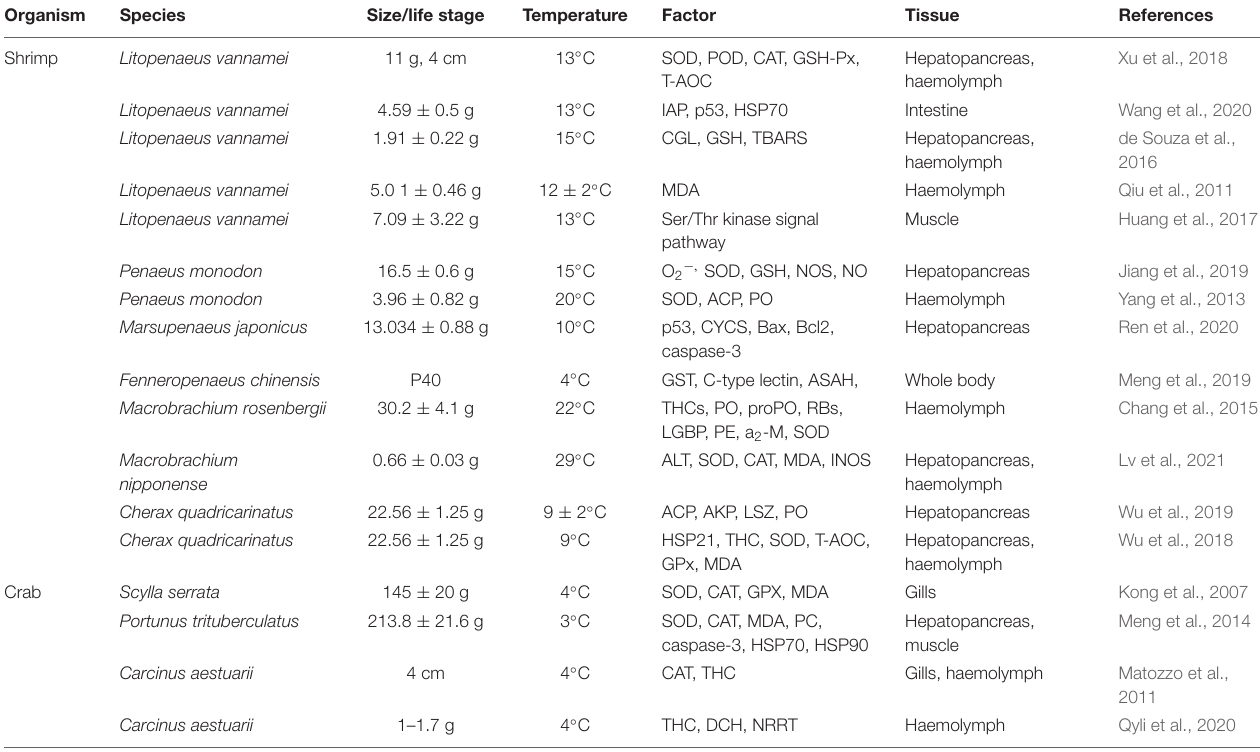
TABLE 1 | Effects of low temperature on immune and antioxidant parameters in shrimp and crab. Organism Species